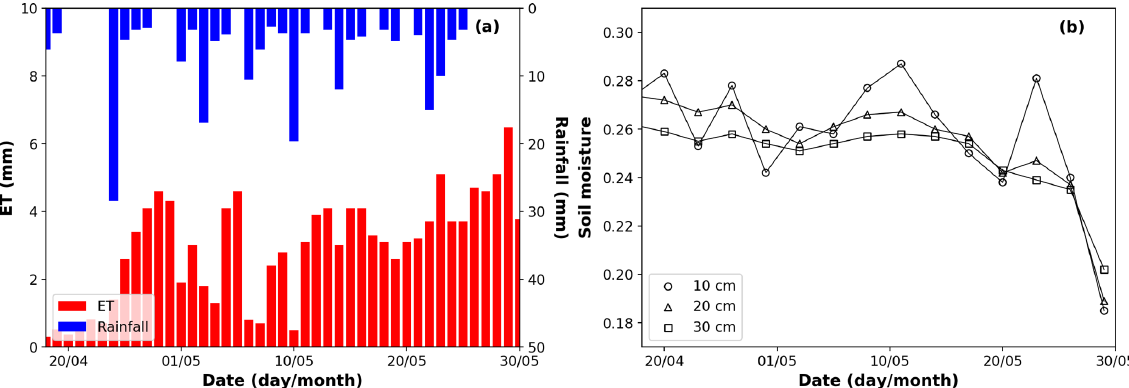
Figure 11. The meteorological information and observed soil moisture over the experimental time. (a) Observed rainfall and calculated potential evaporation. (b) Temporal change of soil moisture data at three different observed depths (10, 20 and